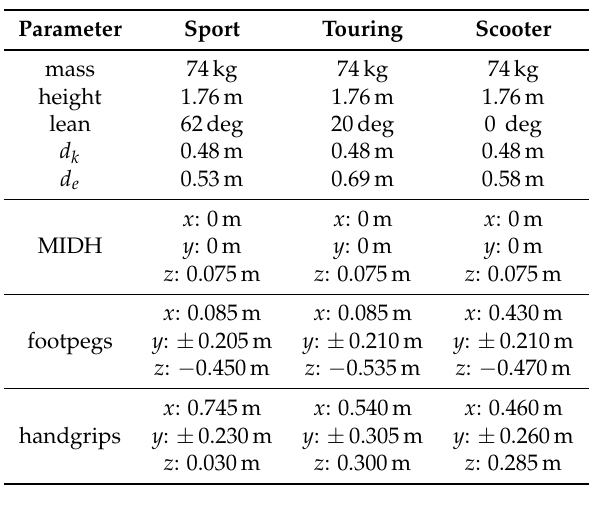
Table 2. Baseline parameters for the rider on the three bikes. The coordinates are given with respect to the saddle